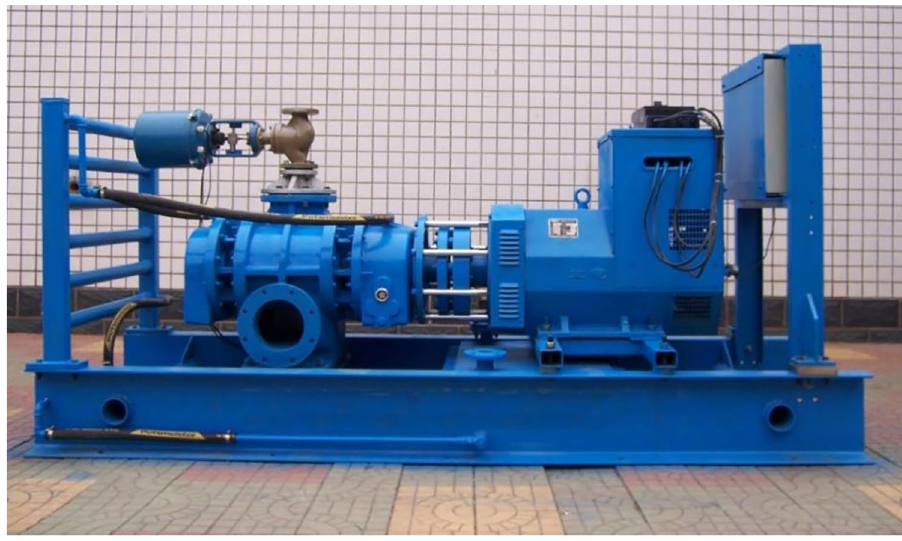
Figure 2. Low-quality waste heat recovery and utilization device with roots power machine as the